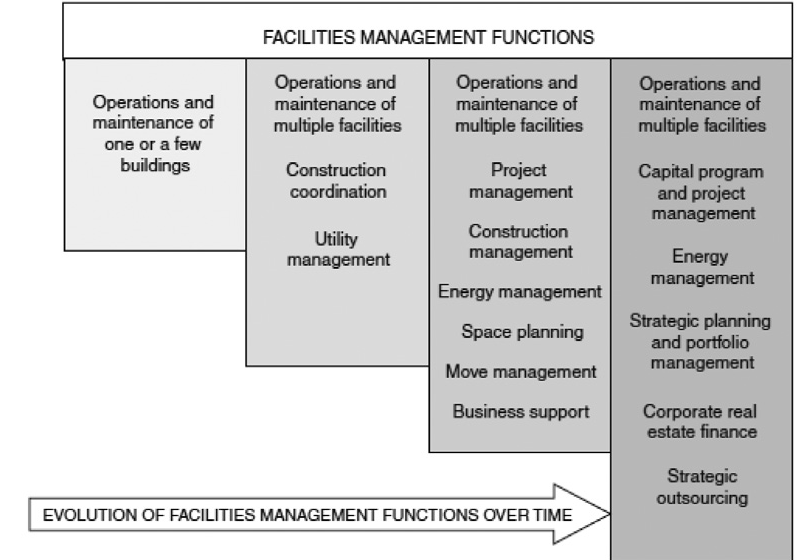
Fig. 1. Evolution of facilities management functions (National Resource Council